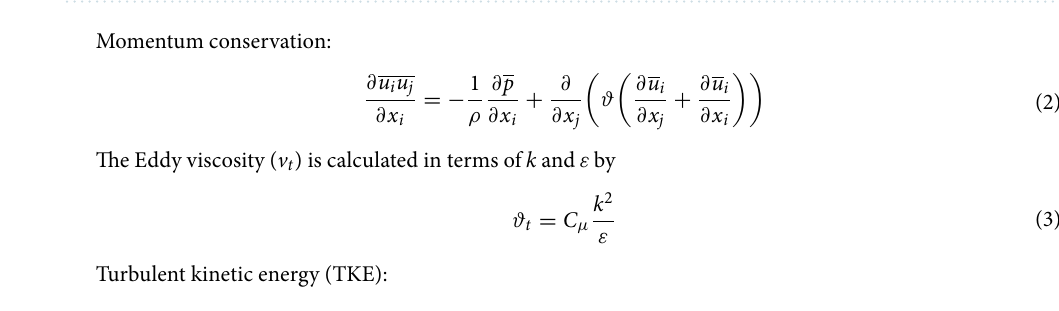
Figure 6. Elements on ( a ) eastern and ( b ) western walls of the